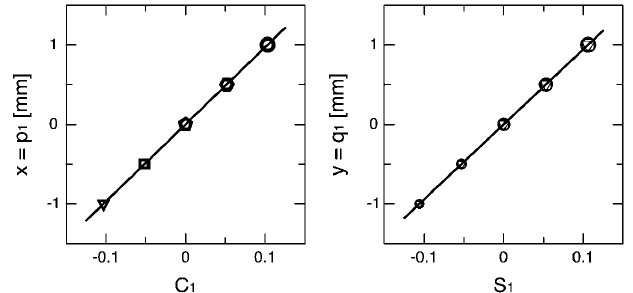
FIG. 13. Relation between p merically calculated BPM with elliptical cross section.